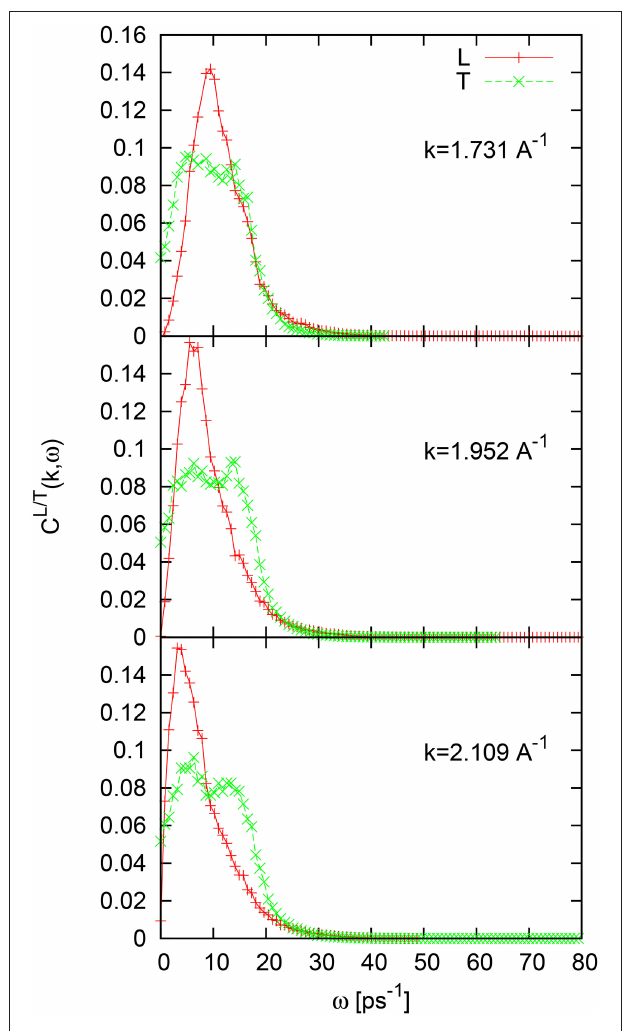
FIGURE 11 | Longitudinal and transverse current spectral functions for liquid Tl for three wave numbers in the second pseudo-Brillouin zone from simulations with